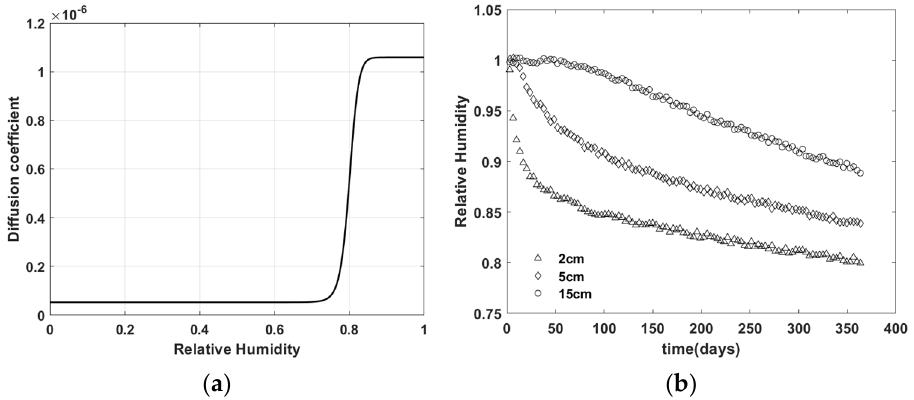
Figure 4. Virtual experiment data with material M2—( a ) moisture diffusion model D; ( b ) relative humidity distribution over time.